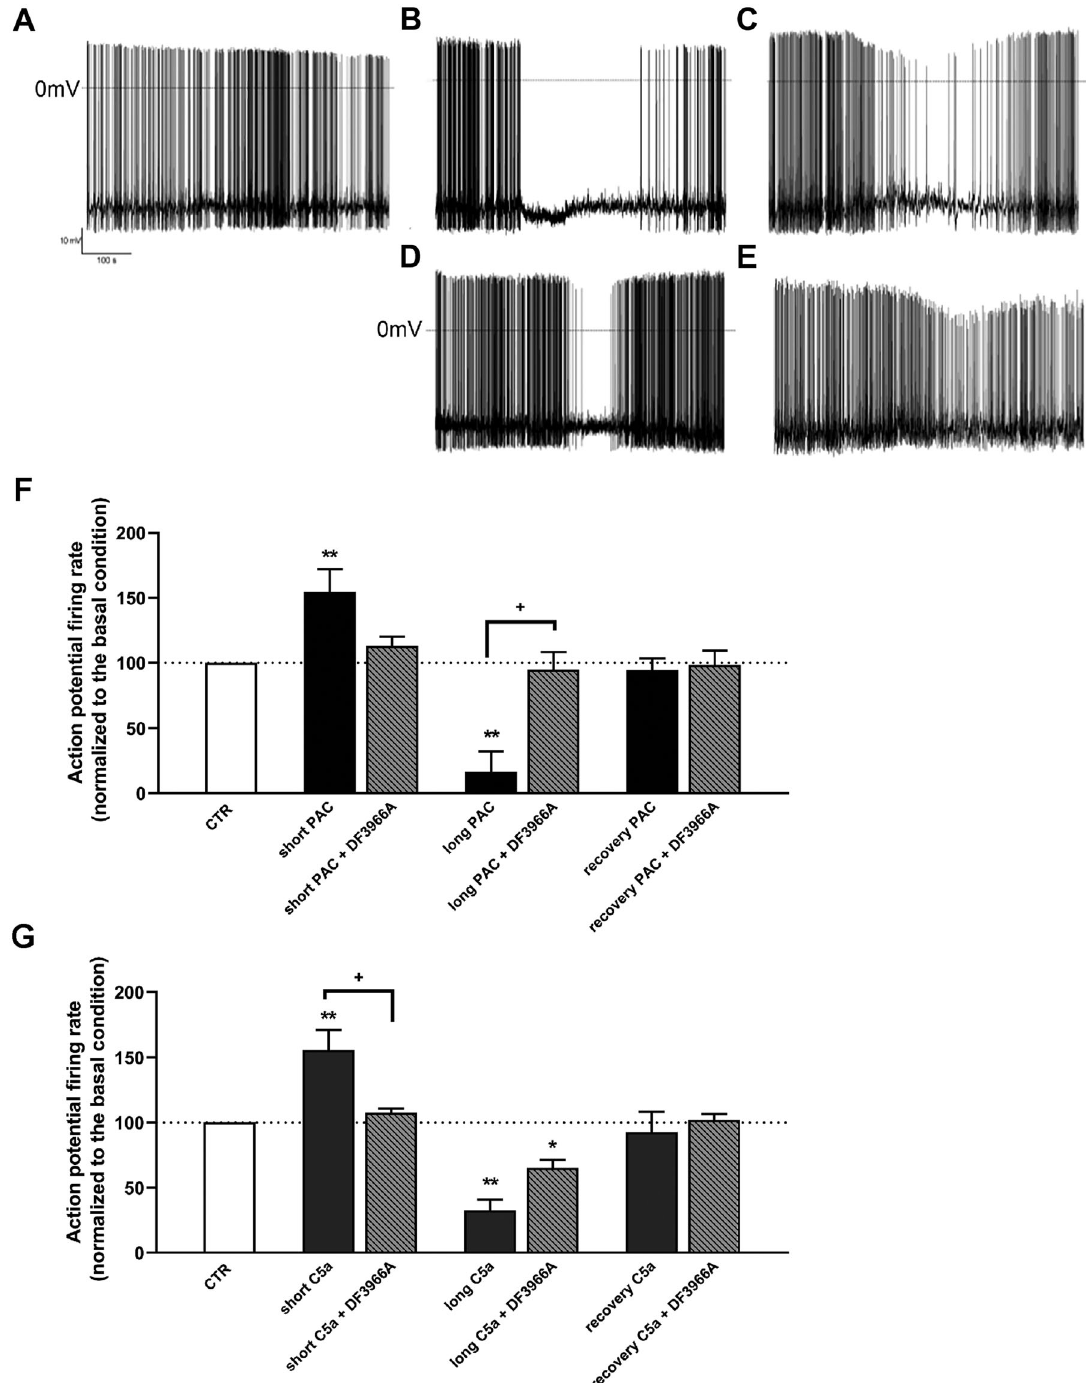
Fig. 5 C5aR1 inhibition counteracts paclitaxel-induced alterations in rodent DRG. Representative trace of electrophysiological recordings in DRG cells maintained under basal conditions ( A ), and in cells challenged with paclitaxel (10 nM) (PAC) ( B ), paclitaxel + DF3966A (1 µM) ( C ), C5a (100 nM) ( D ) or C5a + DF3966A ( E ). Quantitative evaluation of action potential fi ring rate in DRG exposed to paclitaxel alone or in combination with DF3966A ( F ), and C5a alone or in combination with DF3966A ( G ). DRG-derived neurons were cultured for 7 days. Cells were treated for 1 min 30 s (short) or 5 min (long). ** P < 0.005 and * P < 0.05 vs respective basal condition; + P < 0.05 vs paclitaxel or C5a. Data are mean ± SEM of n = 3 different